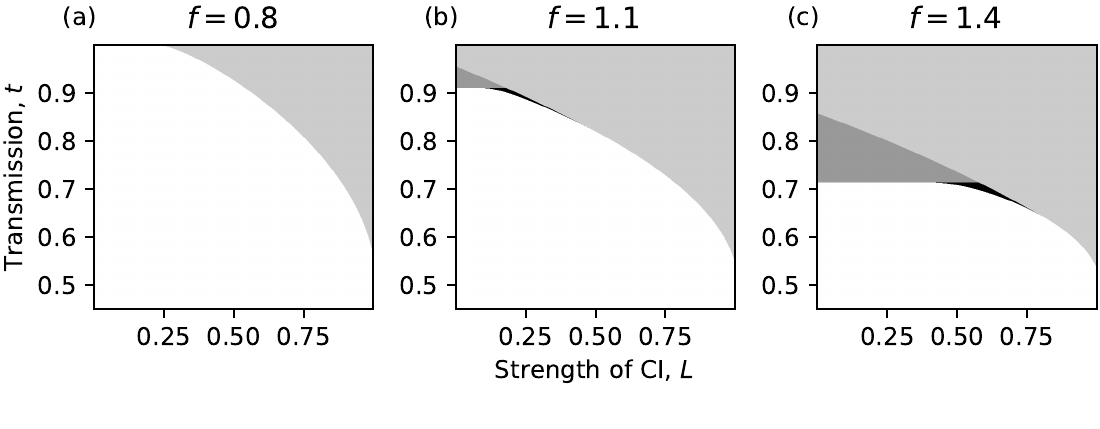
Figure 4. Properties of equilibria of the diplodiploid model shown across parameter space. The parameter regions are categorized as featuring only the trivial equilibrium at p = 0 (white), a non-trivial stable equilibrium ˆ p 2 > 1 / 2 with or without invasion threshold (light grey), and non-trivial stable equilibrium ˆ p 2 < 1 / 2 without (dark grey) or with (black) an invasion threshold. Values of parameter f (fecundity) are indicated above each